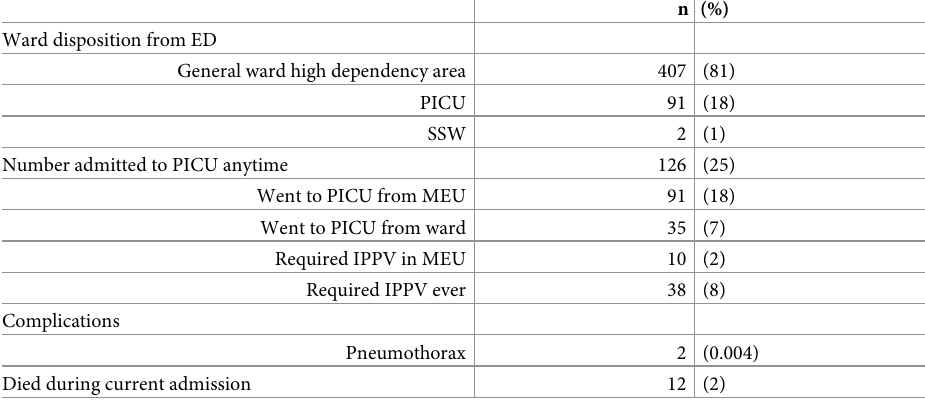
Table 3. Outcomes of the study population commenced on bCPAP in the MEU (N = 500).